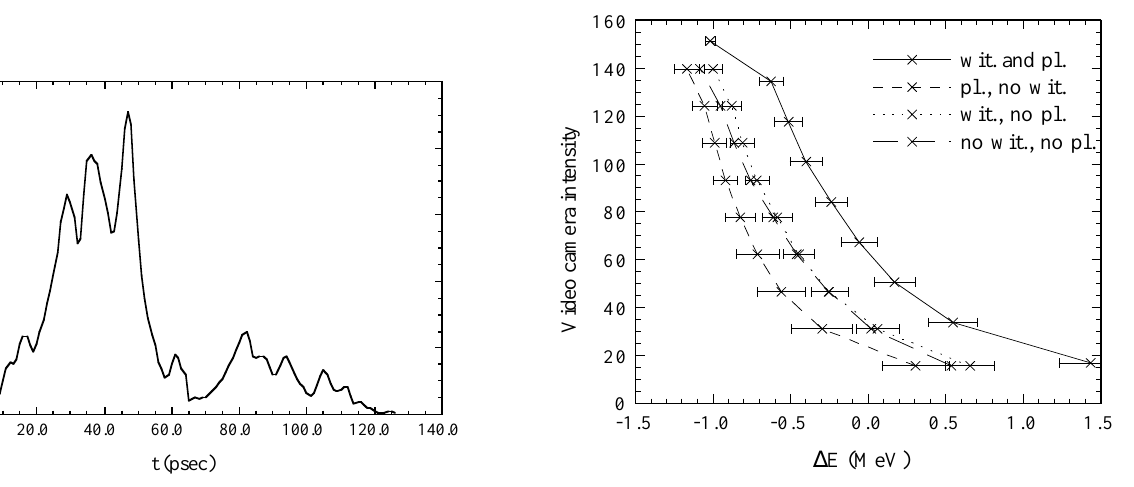
FIG. 4. Streak camera trace of beam-derived ˇCerenkov radia- tion, showing 14.5 MeV drive and witness beam profiles gen- erated simultaneously in the AWA photoinjector.